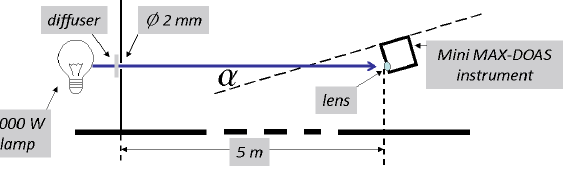
Fig. 3. Set-up of the field-of-view characterization experiment with a light source in the distance. The angle α denotes the rotation in the vertical plane relative to a horizontal starting position of 0 ◦ . At this starting position the light source was at the same height above the table as the lens. The experiment was repeated including a black tube in front of the lens (not drawn), which is used normally to block stray light. Adding the tube did not change the results.